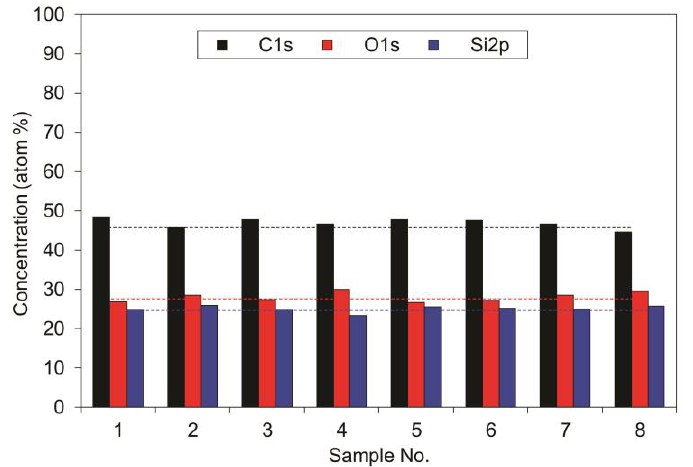
Figure 10. Concentrations of carbon, oxygen and silicon of deposited films at different positions in the PECVD reactor as deduced from XPS survey spectra.